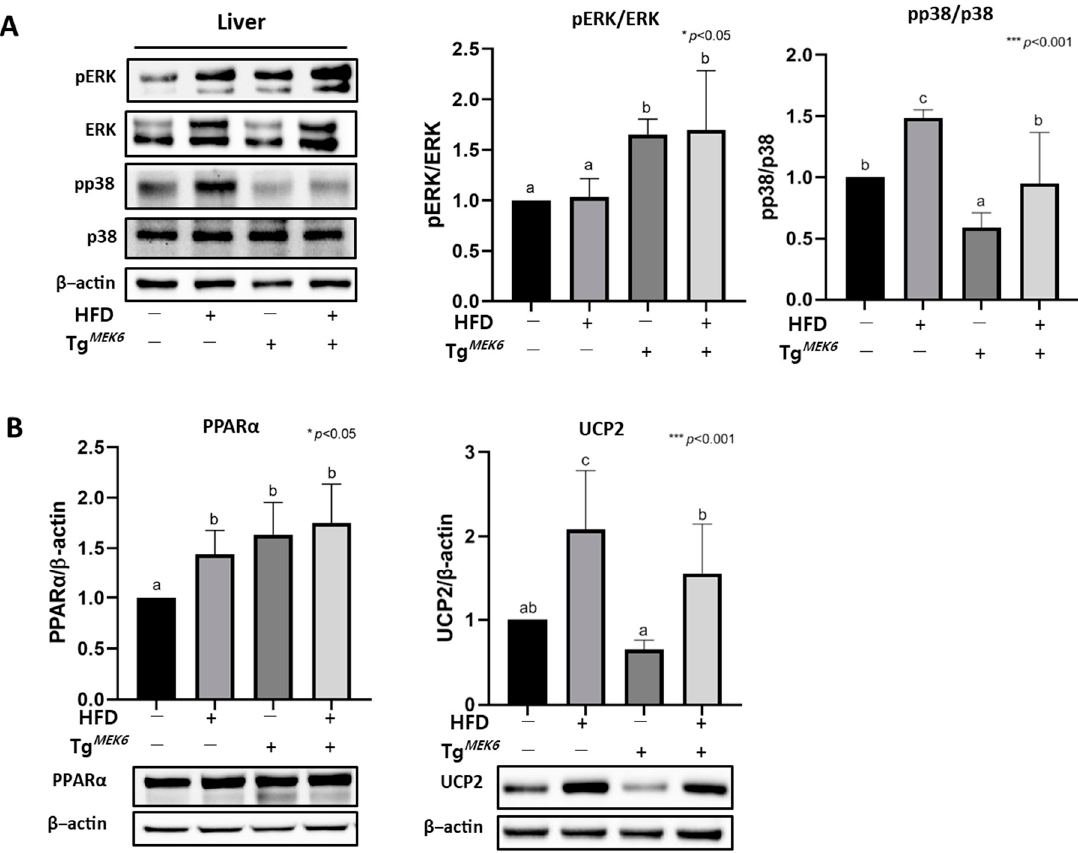
Figure 4. Overexpression of MEK6 modulates protein related to MAPK family (ERK/p38) activation and PPAR α , UCP2 in liver. ( A ) The liver of Tg MEK6 mice was confirmed makers (pERK, ERK, pp38, p38) related to MAPK family and ( B ) protein expression of PPAR α , UCP2 by western blot. Results are expressed as mean ± SD. Data were assessed by one ‐ way ANOVA with Duncan’s test (NS, not significant by unpaired t ‐ test. *; p < 0.05, ***; p < 0.001). Superscript letters (a–c) indicate the significant differences between the groups at p < 0.05. +, treatment or transfection; − , non ‐ treatment or non ‐ transfection.